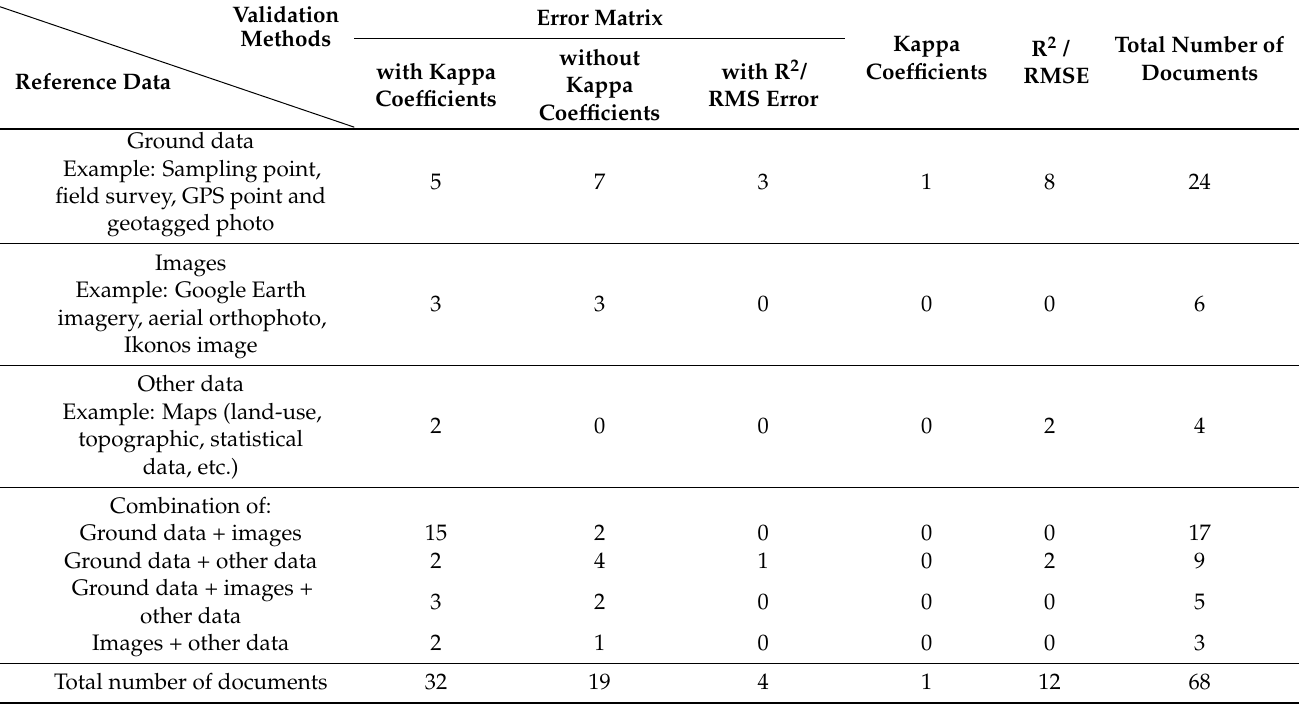
Table 3. Distribution of reference data type and validation methods used with the respective number of documents.